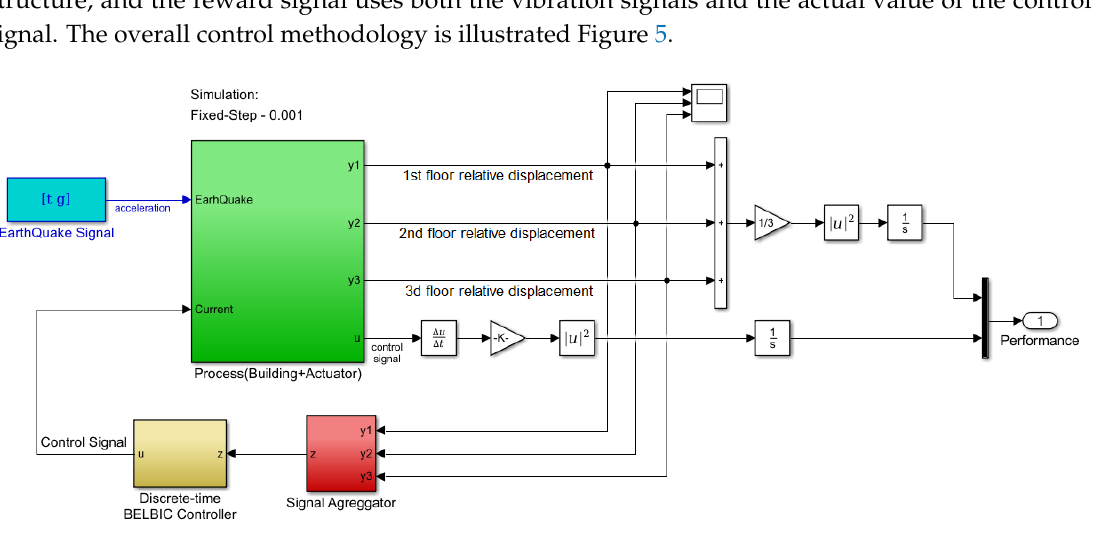
Figure 5. The brain–emotional learning-based intelligent control (BELBIC) control architecture for the three-storey building vibration